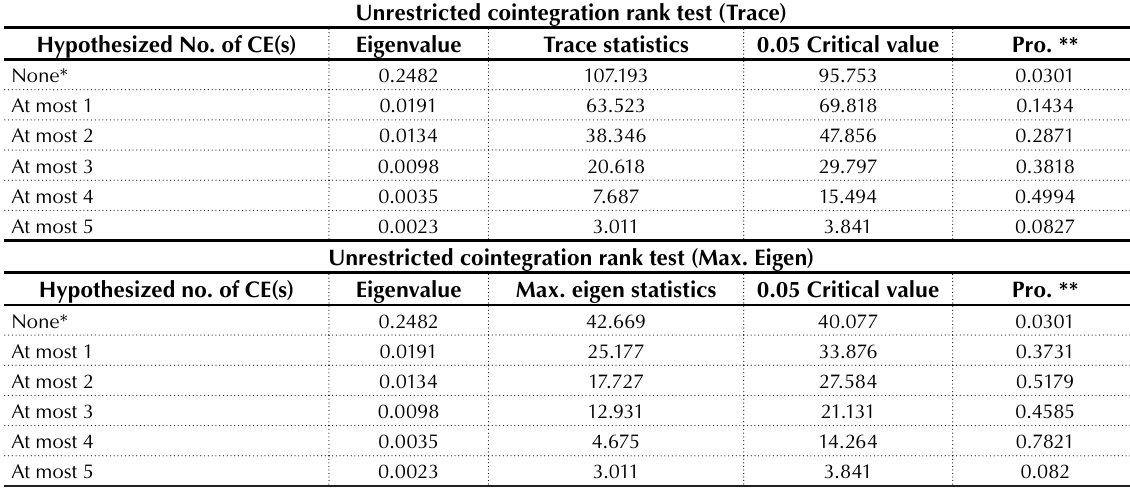
Table 4. Johansen cointegration test results